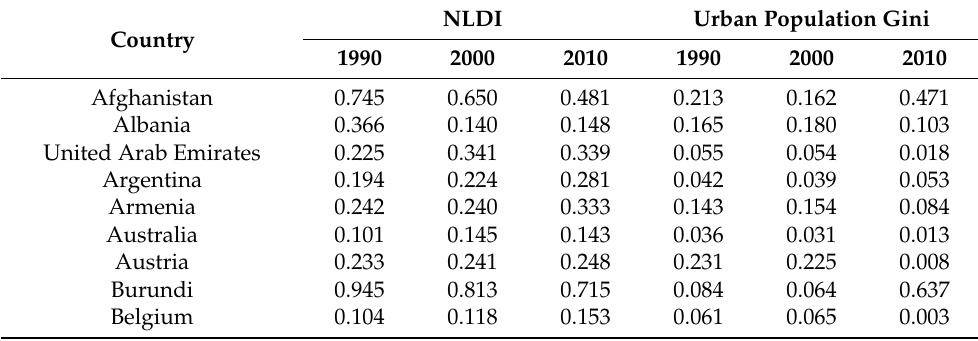
Table A1. Nighttime Light Development Index (NLDI) and Urban Population Gini results for 141 countries and